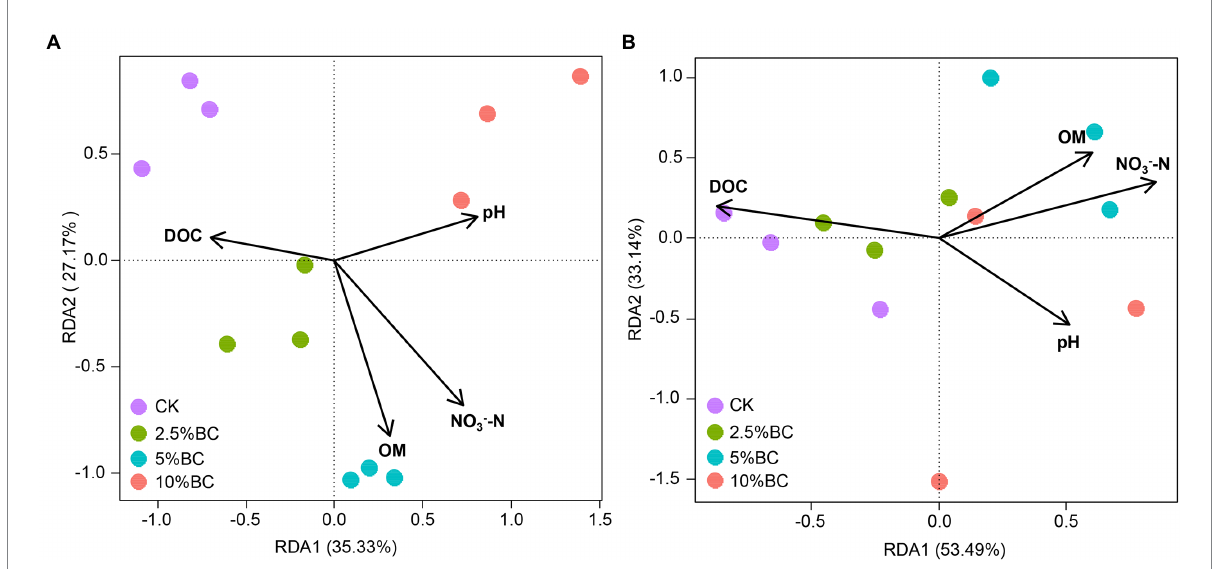
FIGURE 4 Redundancy analysis (RDA) revealing the relationship of selected physicochemical properties with (A) the bacterial community and with the (B) metabolic function of bacterial communities. CK, compost without biochar; 2.5%BC, compost added with 2.5% (w/w) biochar; 5%BC, compost added with 5% (w/w) biochar; 10 BC%, compost added with 10% (w/w)